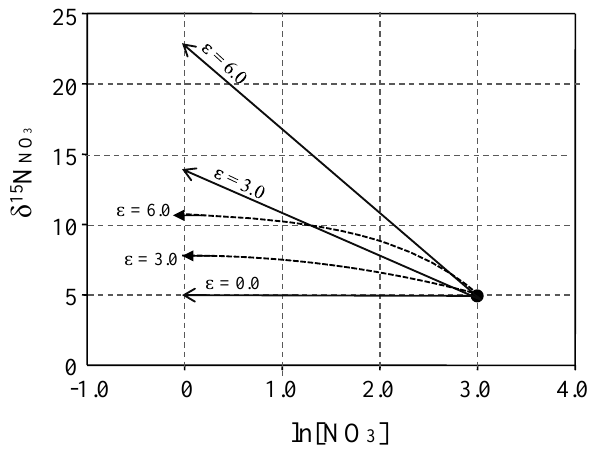
shift for a given [NO 3 ] Fig. 10. Examples of the expected δ 15 N NO 3 (plotted as its natural logarithm) for the case of ε = 0, 3.0, and 6.0, based on both the Rayleigh model (closed system model, solid line) and the steady-state model (open system model, dotted line). When NO 3 is assimilated by organisms with isotopic fractionation, ini- = 5 . 0) will be tial values (e.g., ln[NO 3 ]=3.0 and initial δ 15 N NO 3 shifted following Eq. (1) according to the Rayleigh model in the case of a closed system (i.e., new NO 3 is not continuously supplied) or following Eq. (2) according to the steady-state model in the case of an open system (i.e., new NO 3 is continuously supplied), or, most likely, according to some intermediate condition (e.g., Sigman et al., 1999; Sugimoto et al., 2009).